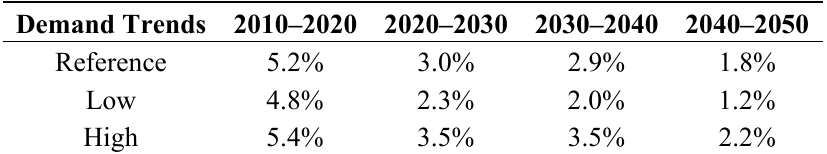
Table 4. Growth rates for transport energy demand in scenarios.